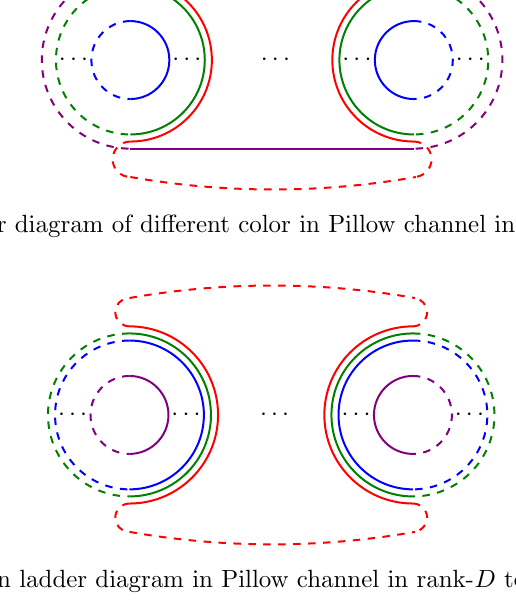
Figure 27. Unbroken and broken ladder diagram contribution of order O ( N D (cid:0) 1 ) in rank- D tensor